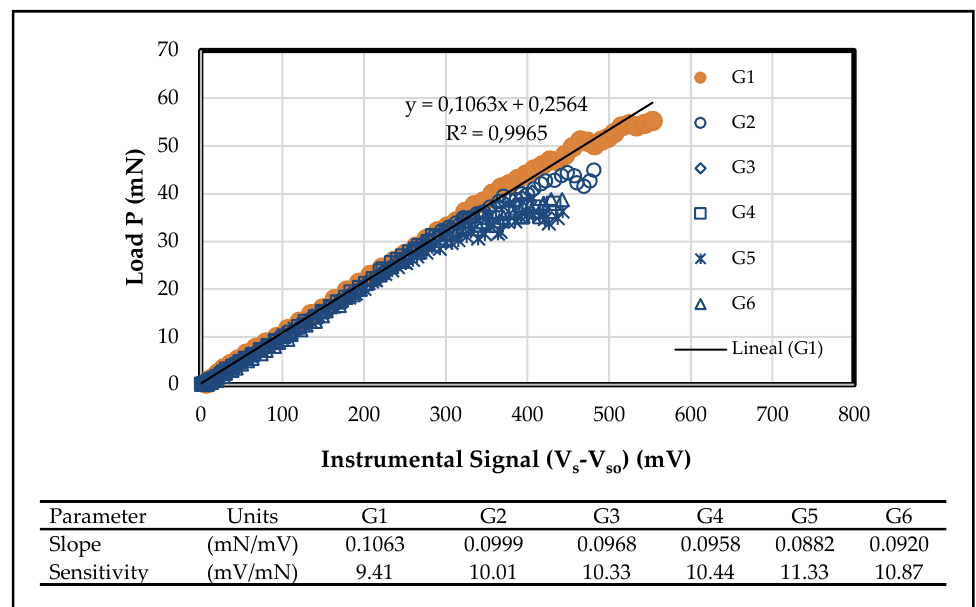
Figure 3. Relationship between instrumental signal and load P.